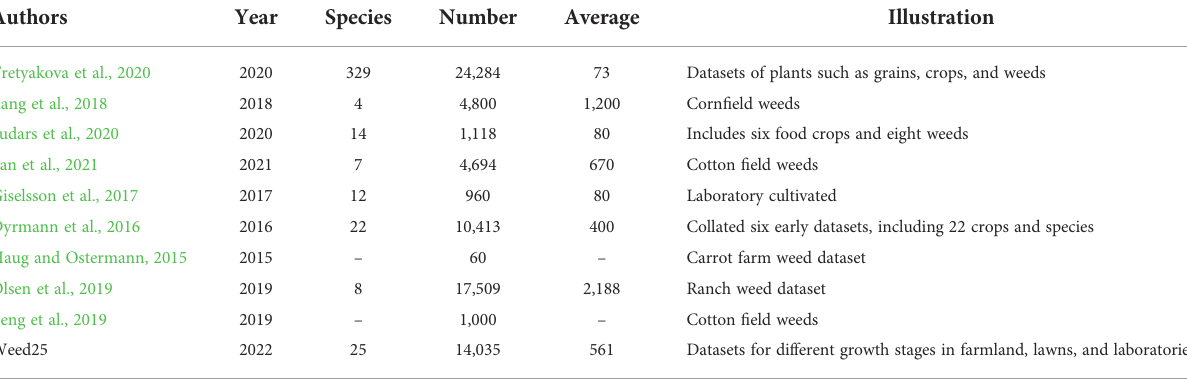
TABLE 3 Weed25 compared with other weed